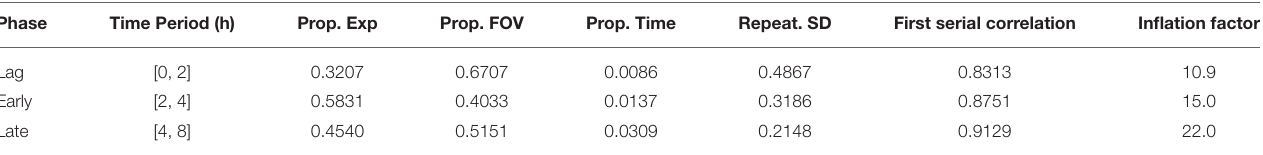
TABLE 1 | Repeatability standard deviation for each phase of biofilm growth and the proportion (Prop.) of variance attributable to each of experiment, field of view, and